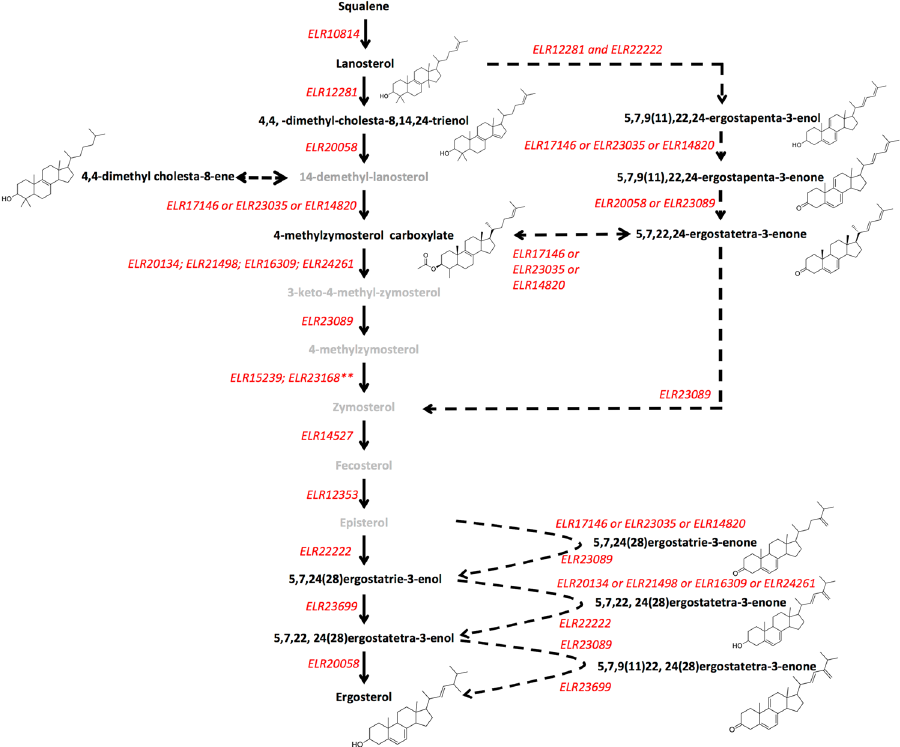
Figure 2. Proposed scheme of sterol biosynthesis in Acanthamoeba . Products and intermediates in black were identified by GCMS while those in grey were not. Candidate enzymes, named according to their GenBank Accession numbers, are annotated in red. ** Denotes that this protein is not an enzyme but an anchor